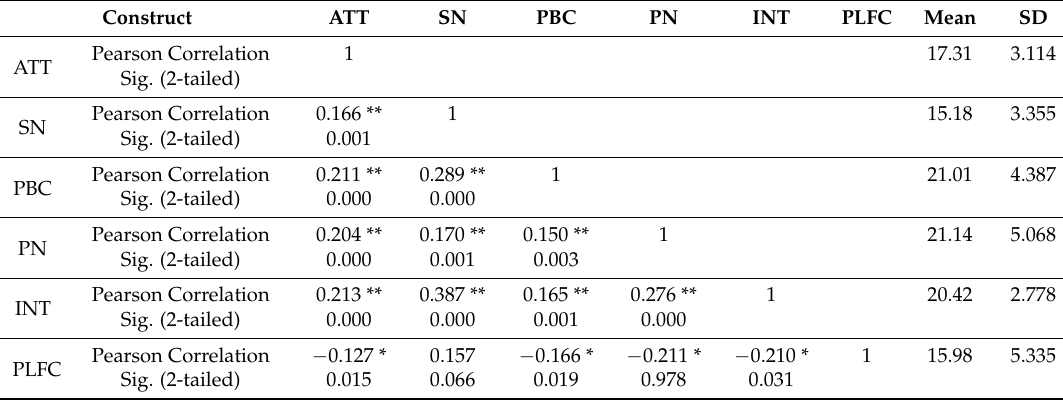
Table 2. Descriptive Statistics and the Correlation Coefficient Matrix of the